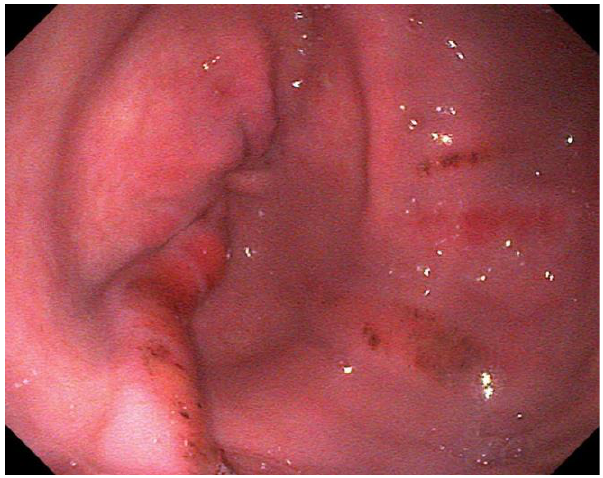
Figure 3. Multiple, linear, flat, hemorrhagic lesions of the pyloric mucosa.